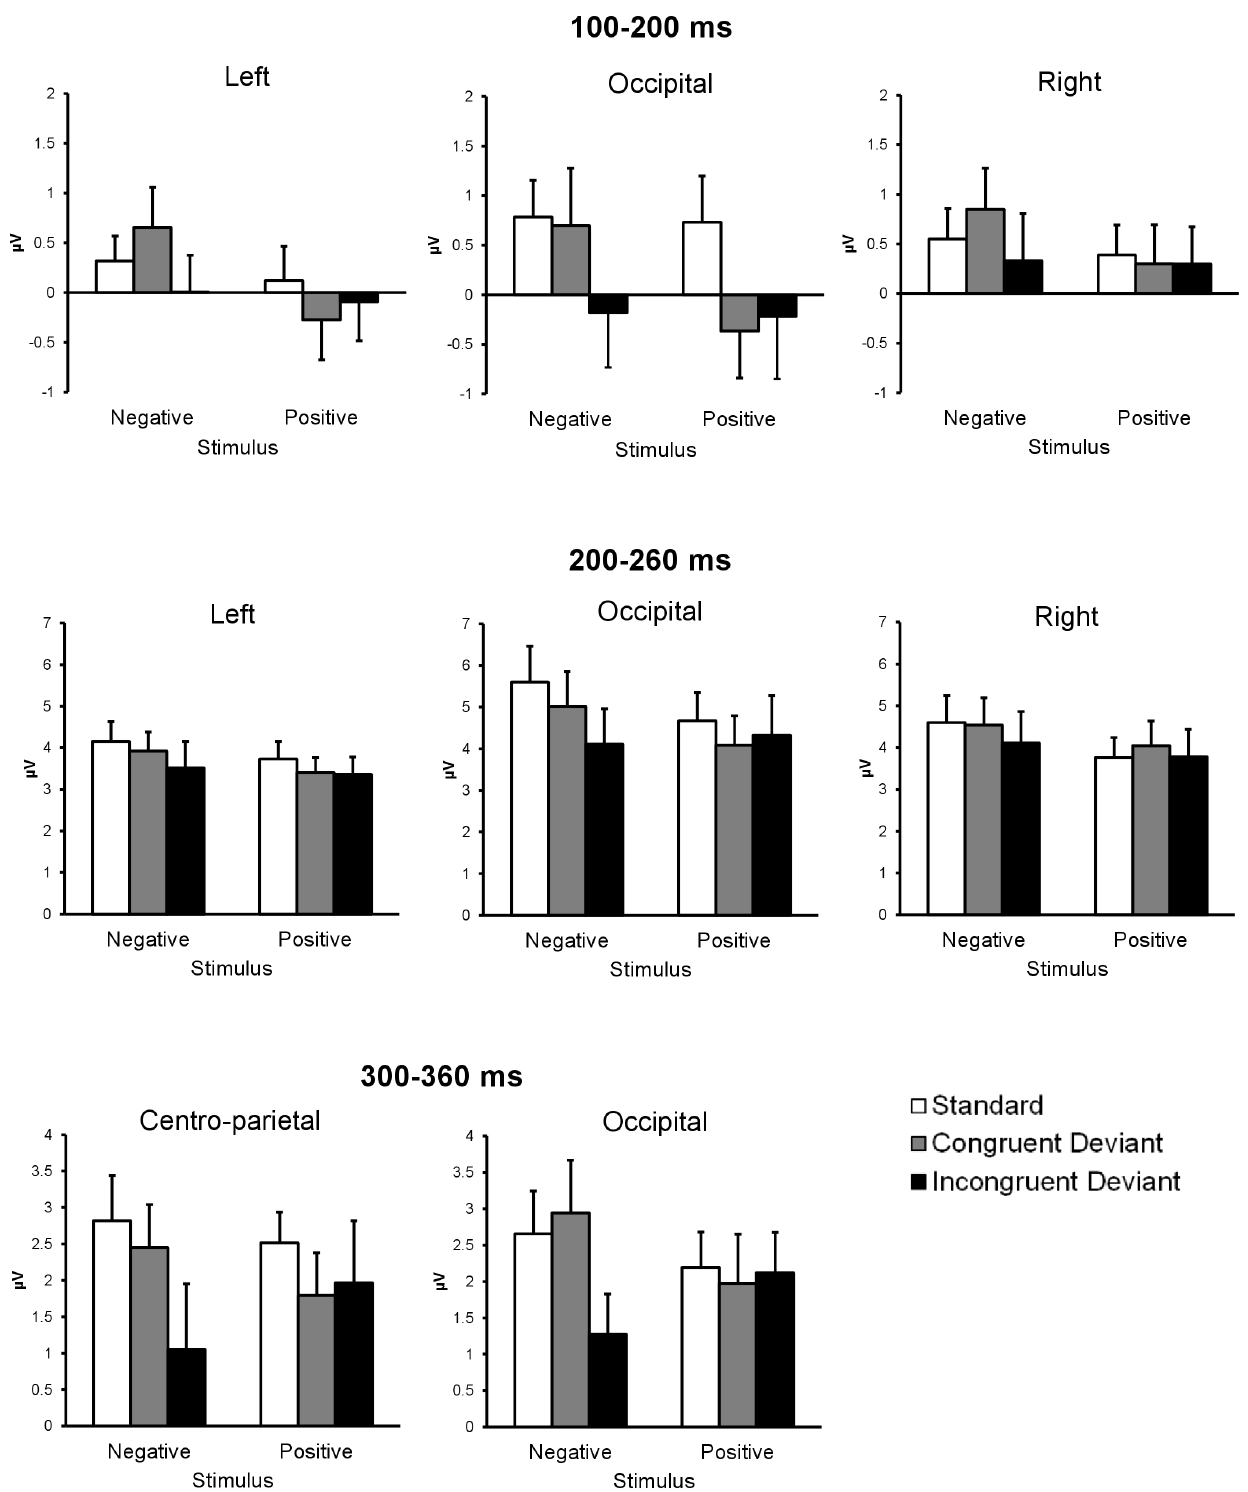
Figure 5. Mean amplitudes and SEMs of ERPs for each condition. ERP amplitudes for standards, emotionally congruent deviants, and emotionally incongruent deviants in negative and positive sequences. For all of the time windows, ERP amplitudes were averaged across three occipital electrodes (O1, O2, and Oz). In addition, for 100–200 ms and 200–260 ms, ERP amplitudes were averaged across two posterior electrodes over the right hemisphere (TP8 and P8), and two homologous electrodes over the left hemisphere (TP7 and P7). For 300–360 ms, ERP amplitudes were averaged across three centro-parietal electrodes (FCz, Cz, and CPz).